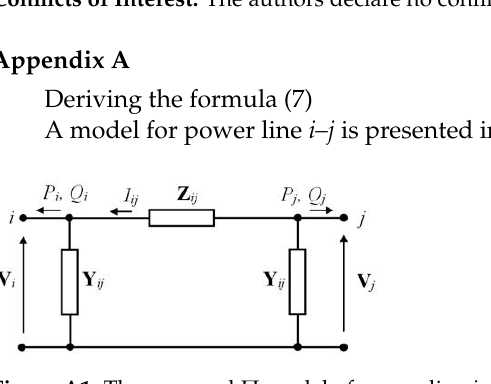
ij = r ij + j x ij , Y ij = j 0.5 b ij